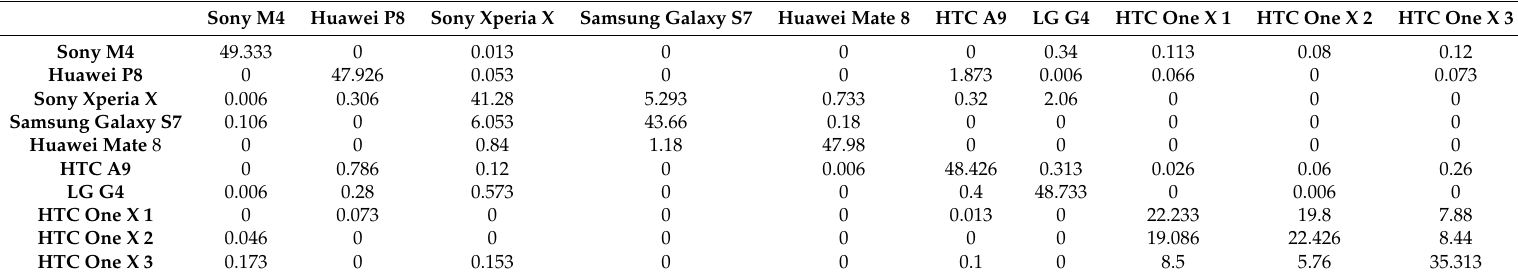
Table 5. Confusion matrix based on SVM and optimal values for the digital output generated by the magnetometer on the Z axis. Values have been averaged over the 50 repetitions.